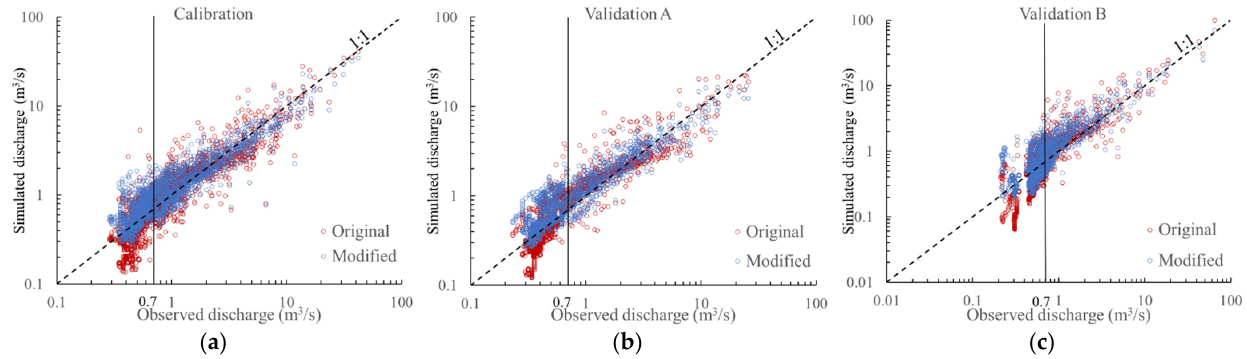
Figure 8. The relationship of observed and two simulated discharges for the calibration period ( a ) and validation periods A ( b ) and B ( c ).